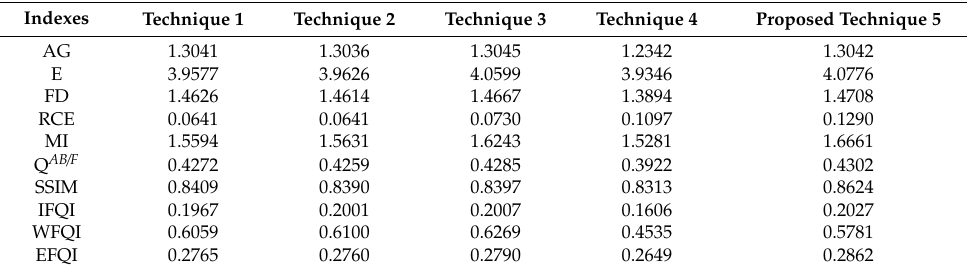
Table 6. Objective evaluation indexes of fused underwater port